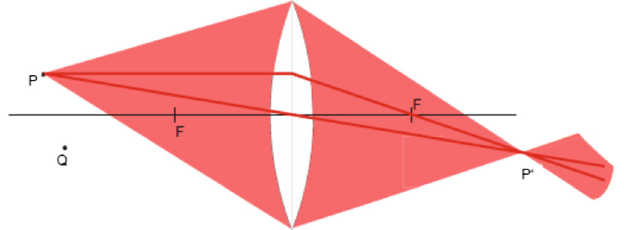
FIG. 9. Point-to-point mapping